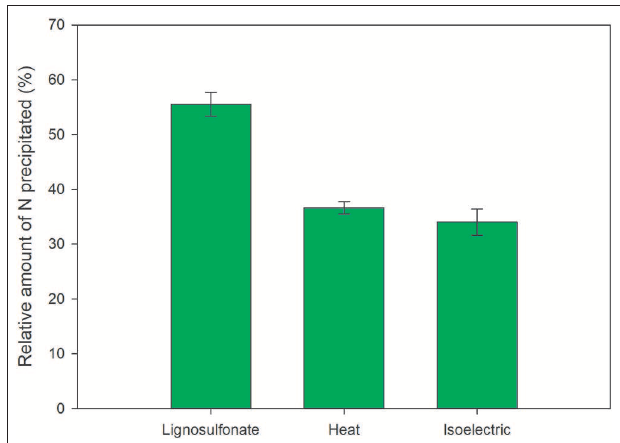
FIGURE 2 | Relative amount of total N precipitated from spinach juice for the three different treatments. Values are means and standard deviation of three replicates.